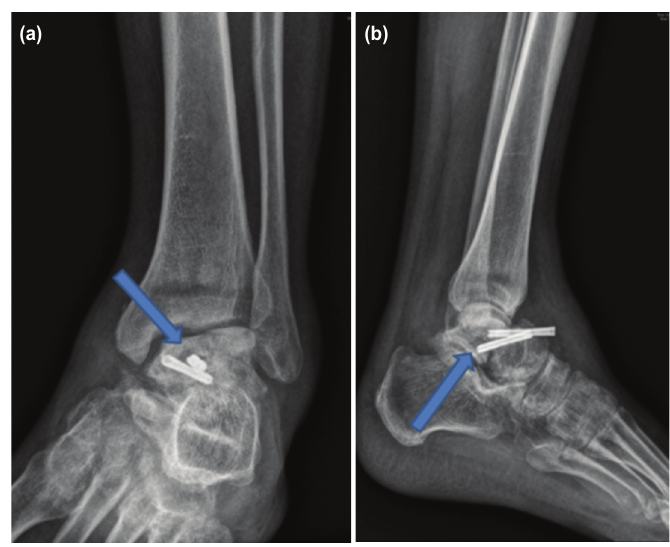
(a, b) Pre-operative AP and lateral radiographs of Patient 4. Fig. 1: